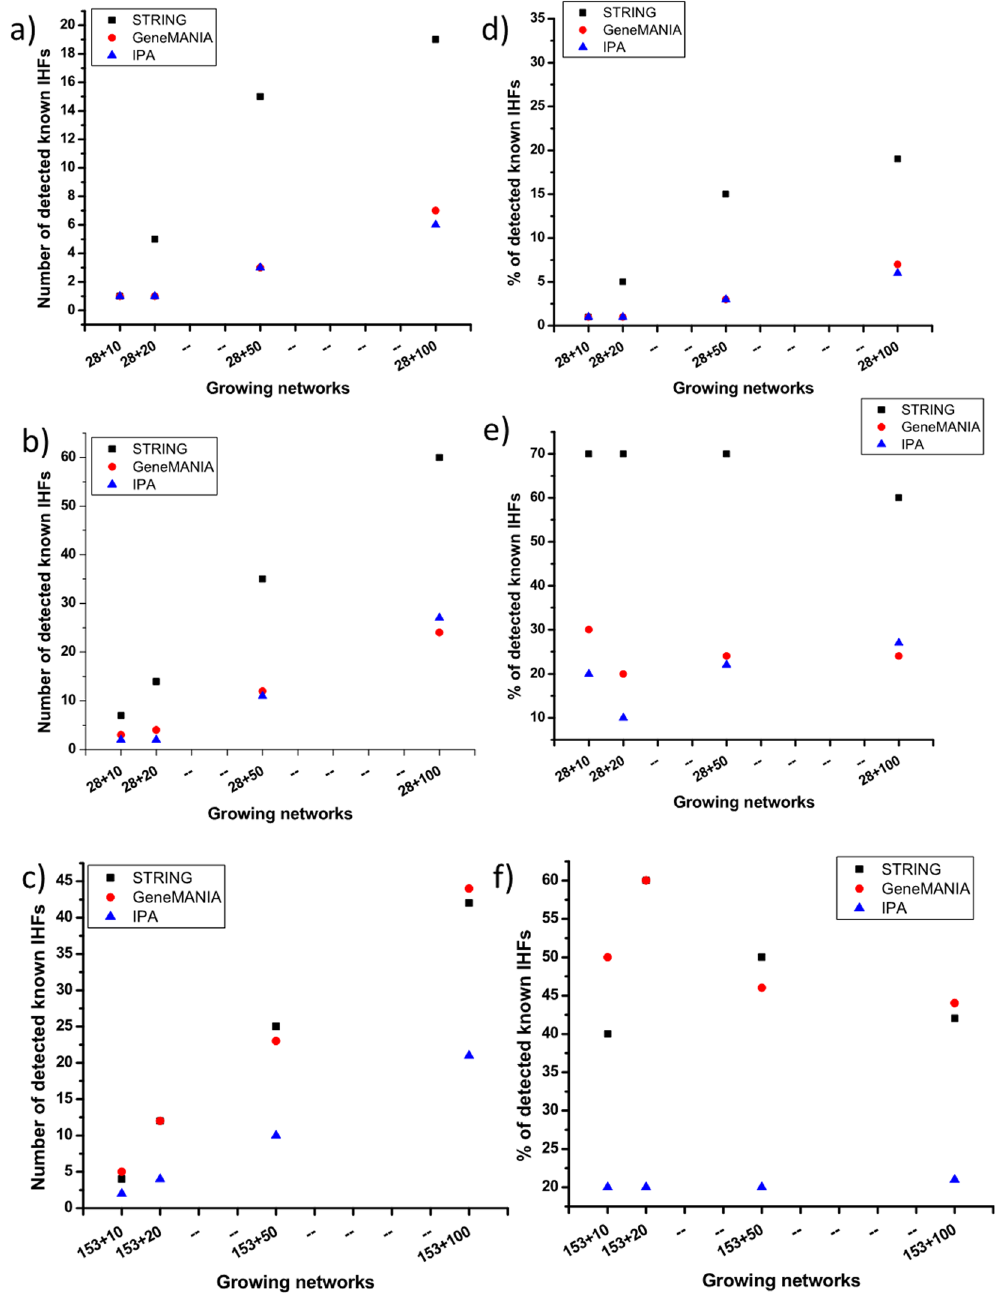
Figure 1. The trend of network growing tools in detecting known IHFs. ( a ) Number of detected known IHFs upon growing networks with the small set (28 IHF) seeds and 153 known IHFs as positive set. ( b ) Number of detected known IHFs upon growing networks with the small set (28 IHF) seeds and 1463 known IHFs as positive set. ( c ) Number of detected known IHFs upon growing networks with medium set (153 IHFs) seeds and 1463 known IHFs as positive set. ( d ) Percentage of detected known IHFs upon growing networks with the small set (28 IHF) seeds and 153 known IHFs as positive set. ( e ) Percentage of detected known IHFs upon growing networks with the small set (28 IHF) seeds and 1463 known IHFs as positive set. ( f ) Percentage of detected known IHFs upon growing networks with medium set (153 IHFs) seeds and 1463 known IHFs as positive